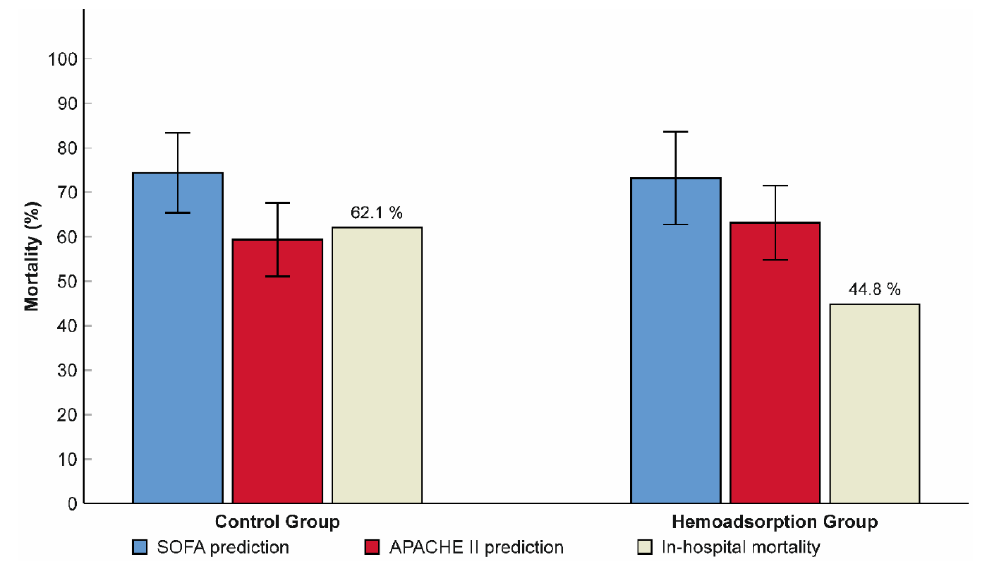
Figure 3. Relationship between predicted and observed in-hospital mortality rates in patients from the hemoadsorption and control groups. N = 58. Data are presented as means and frequency (%). Error bars show 95% confidence intervals. SOFA: sequential organ failure assessment; APACHE II: acute physiology and chronic health evaluation II.